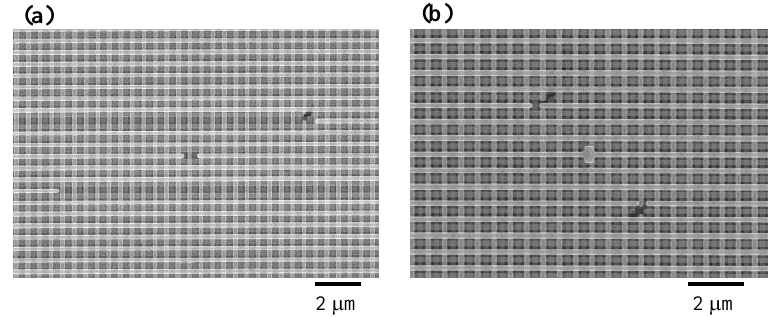
Figure 14. Introduction of waveguides and nanocavities into 3D photonic crystals ( a , b ).